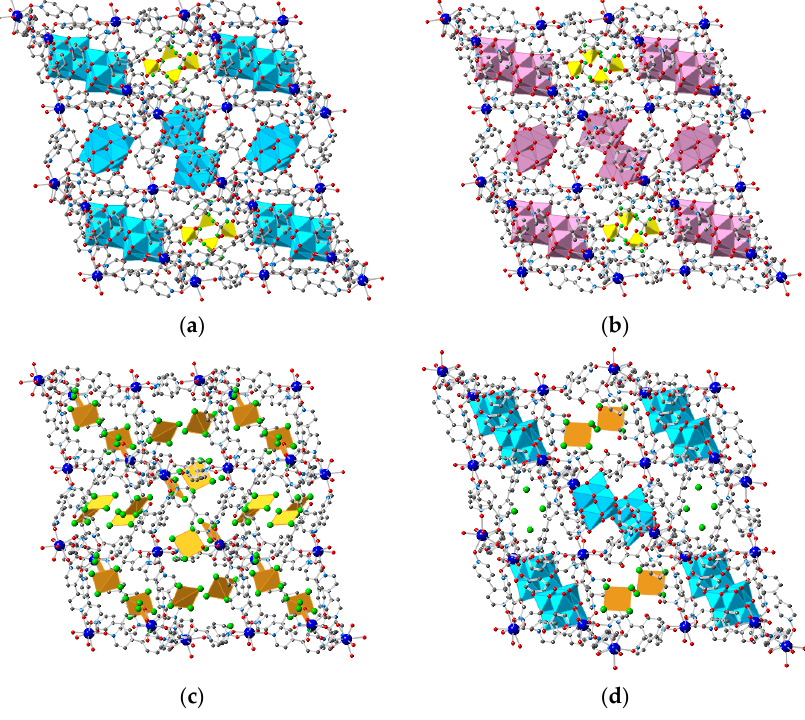
Figure 4. Crystal structures of the anion exchanged solids: ( a ) 1–W 6 O 19 ; ( b ) 1–Mo 6 O 19 ; ( c ) 1–AuCl 4 and ( d ) the mixed system 1–W 6 O 19 –AuCl 4 . Color code of the framework as in Figure 1. [W 6 O 19 ] 2 − [Mo 6 O 19 ] 2 − , [AuCl 4 ] − and Cl − anions shown in blue , purple , orange and green , respectively. In both 1–Mo 6 O 19 and 1–W 6 O 19 , three POM units are incorporated per asymmetric unit of the MOF, thus resulting in a compound of stoichiometry [Gd(bipyNO) 4 ] 3 (POM) 3 (TfO) 3 . The two compounds present the POM 2 − anions located in the same positions of the structure, which